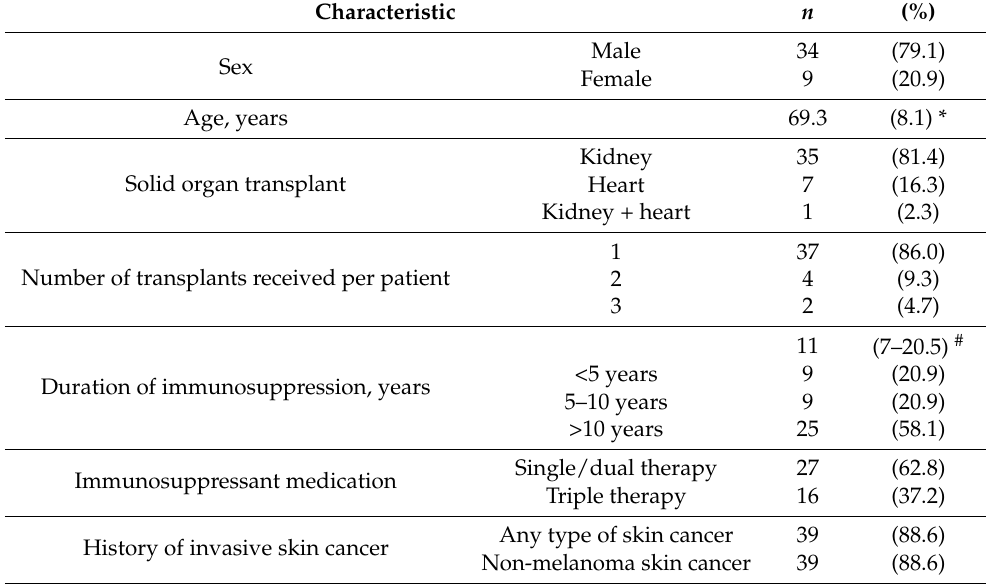
Table 1. Demographic and clinical characteristics of solid organ transplant recipients ( n = 43).